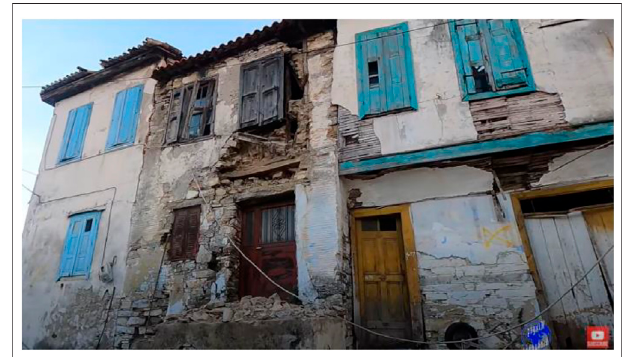
FIGURE 15 | Examples of stone in fi lled (building in the middle) and ba ğ dadi cladded (building on the right) timber-masonry homes (in Samos, picture from Mikres Diadromes Samou,